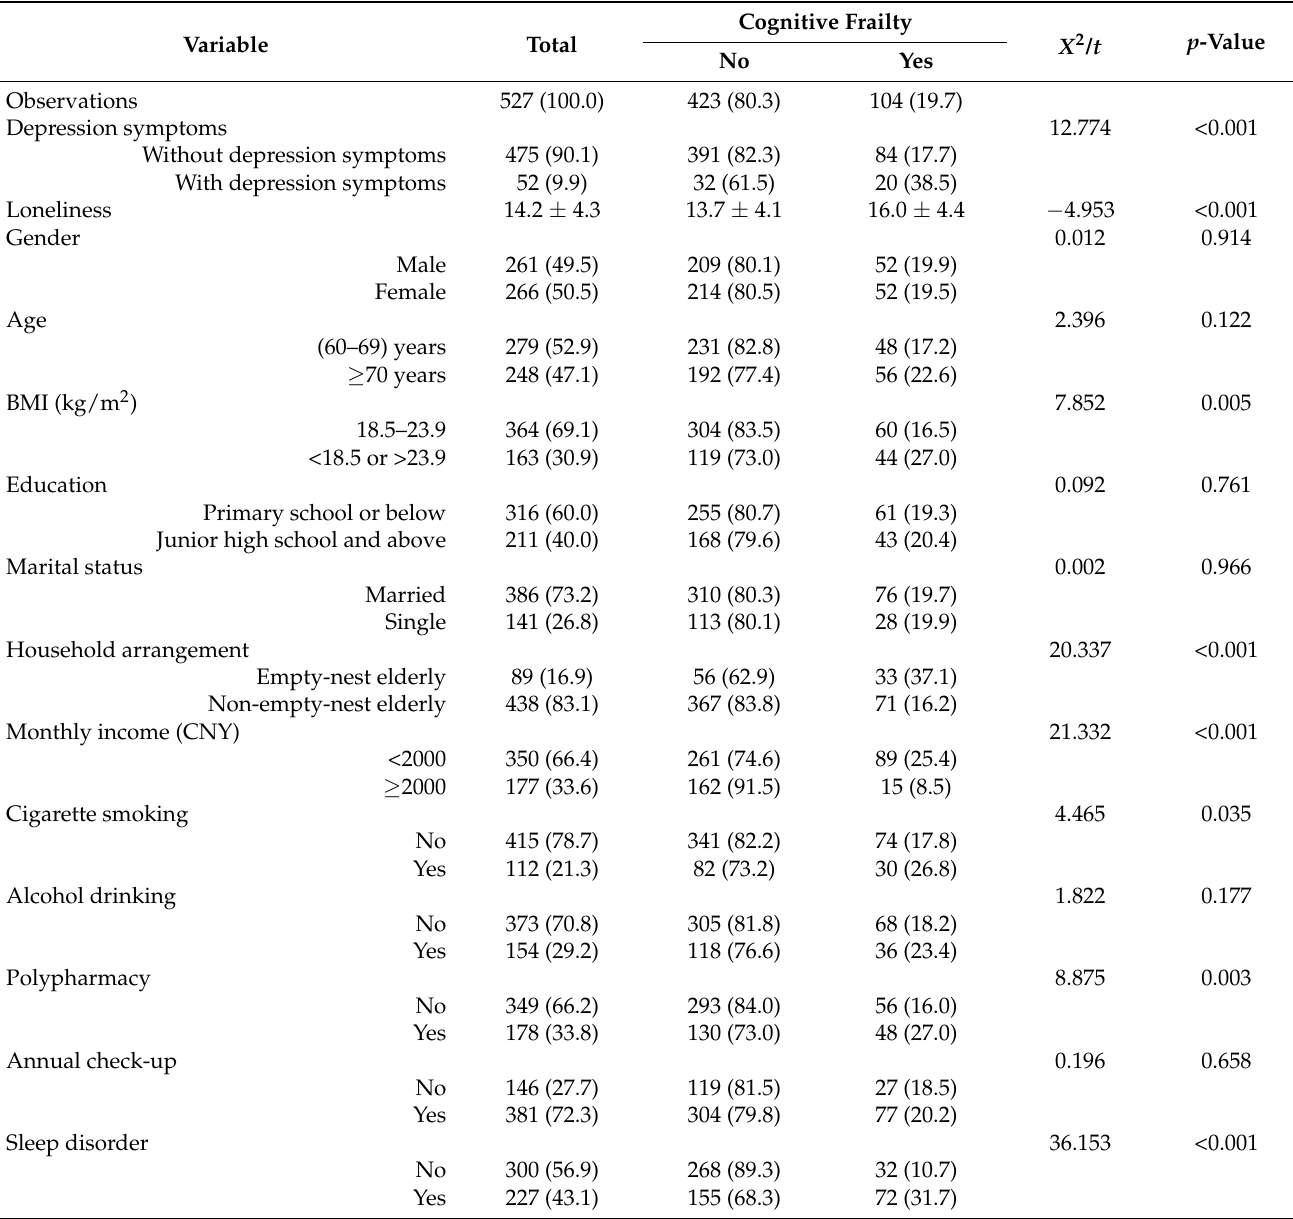
Table 1. Description and univariate analysis of cognitive frailty among community-dwelling older adults ( n =